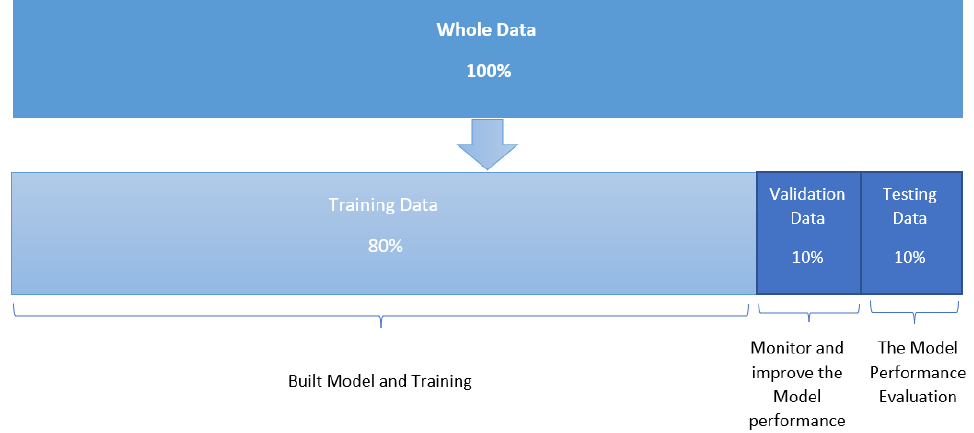
Figure 4. Division of the dataset into training, verification, and testing